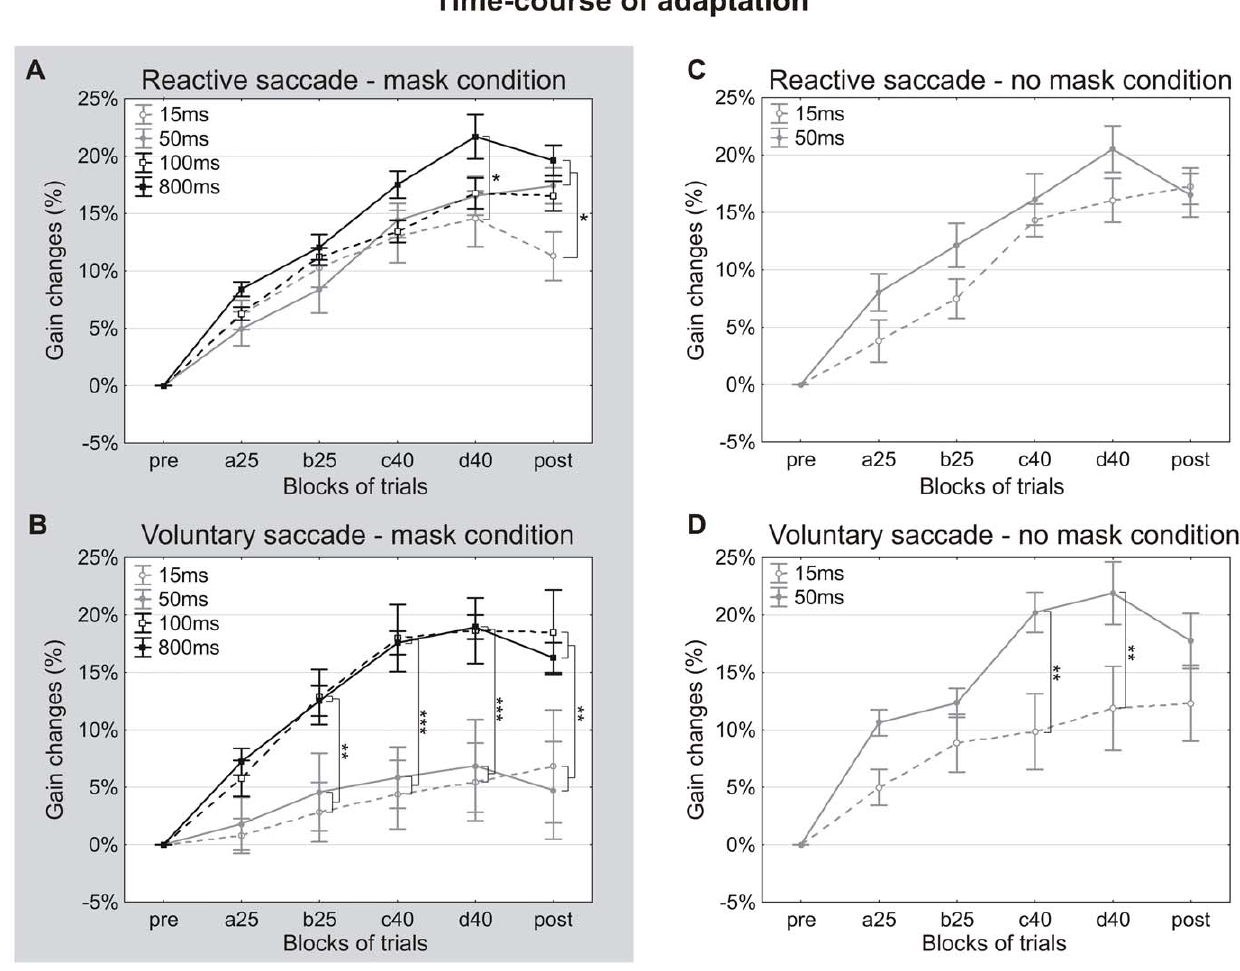
Figure 2. Time-course of the adaptation of reactive and voluntary saccades. Mean gain change is represented as a function of the blocks of trials and superimposed for the different post-saccadic durations of jumped target in the mask condition (grey background – A, B) and no-mask condition (white background – C, D), for reactive (A, C) and voluntary (B, D) saccades adaptation. Mean gain change was calculated across the 5 subjects of each experimental session. Gray lines indicate the gain changes for the shortest target durations (dashed lines: 15 ms – solid lines: 50 ms) and black lines indicate the gain changes for the longest target durations (dashed lines: 100 ms – solid lines: 800 ms). The blocks of trials are: pre- adaptation (pre), adaptation blocks with an intra-saccadic step of 25% of initial target eccentricity (a25, b25) or of 40% (c40, d40) and post-adaptation (post). Error bars are SEMs. Significant differences of gain changes between the target durations are indicated by * (p , 0.05), ** (p , 0.01) and *** (p ,